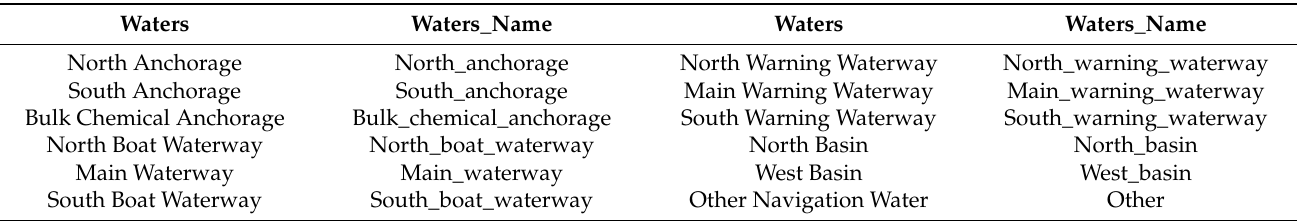
Table 4. Renaming navigable waters.